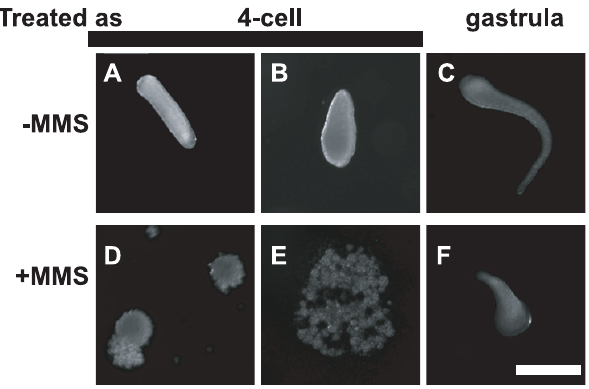
Figure 3. Survival after MMS treatment of cleavage and gastrula stage embryos. (A, B, D, E) Embryos in the 4-cell stage were treated with 0% ( 2 ) or 0.1% ( + ) MMS for one hour. Embryos were transferred to drug-free FSW and examined after 24 hr. All of the control 4-cell stage embryos survived as indicated by their ability to reach the gastrula and planula stages (A, B). Most drug-treated 4-cell embryos did not survive as indicated by signs of disintegration (D, E). (C, F) Gastrula stage embryos at 14–16 hr after the first sign of spawning were treated with MMS and their survival examined as above. All of the control embryos and most of the MMS-treated embryos survived as indicated by their ability to reach the swimming planula stage. Development appears slower after incubation in MMS, but this issue remains to be studied rigorously. Animals in C and F were of similar size but oriented differently. Scale bar =200 m M.